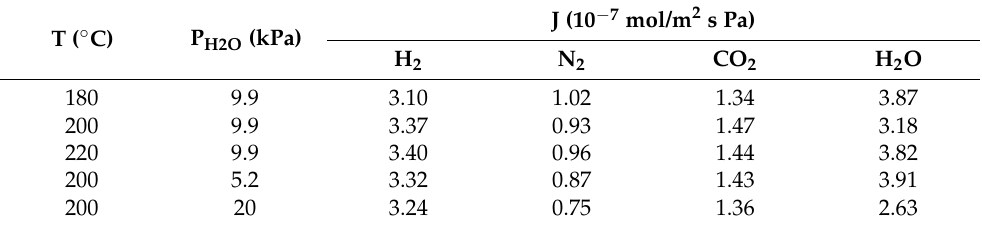
Table 1. Permeance (J) of each gas obtained with the single-layer silicone membrane with different temperatures and water partial pressures in the feed.